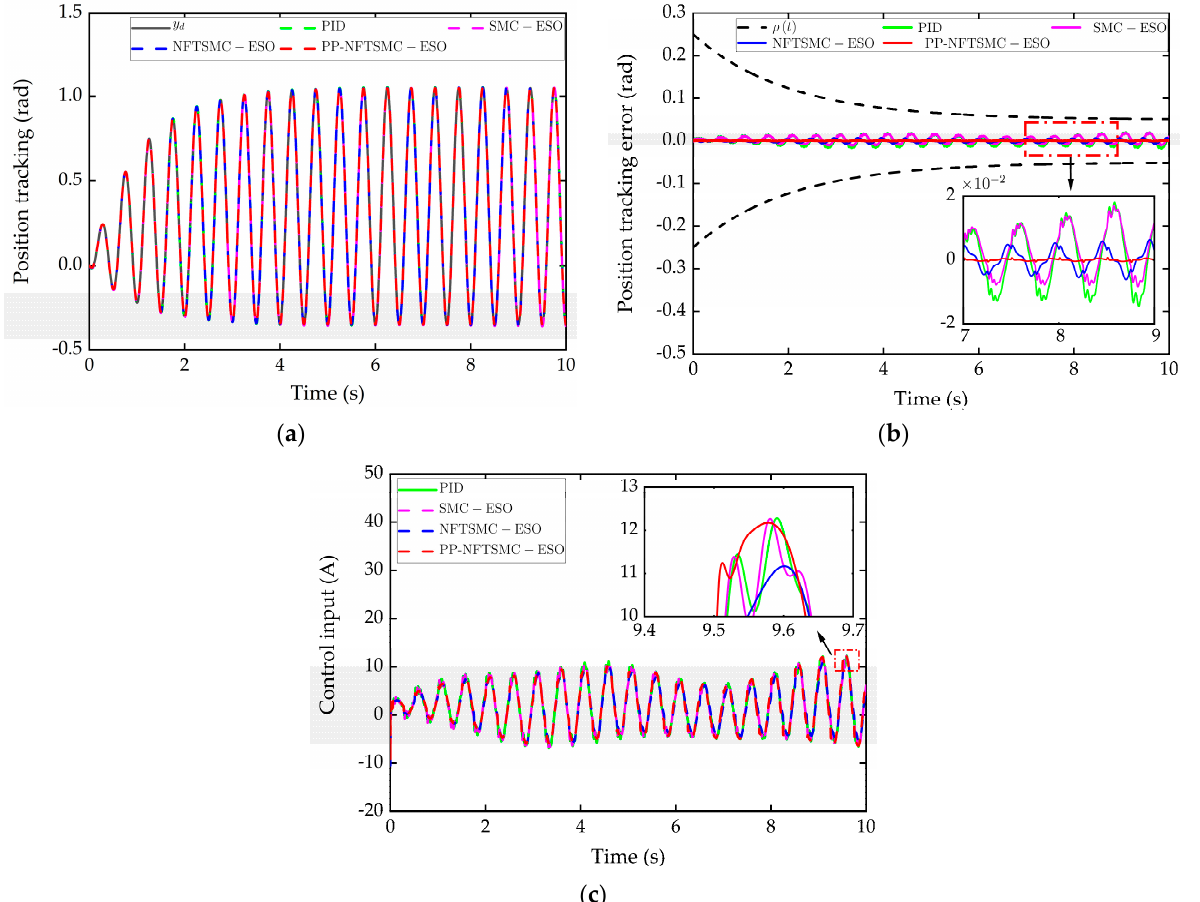
Figure 7. Position-tracking performance of fast motion with the four controllers. ( a ) Position response. ( b ) Position-tracking error. ( c ) Control input.